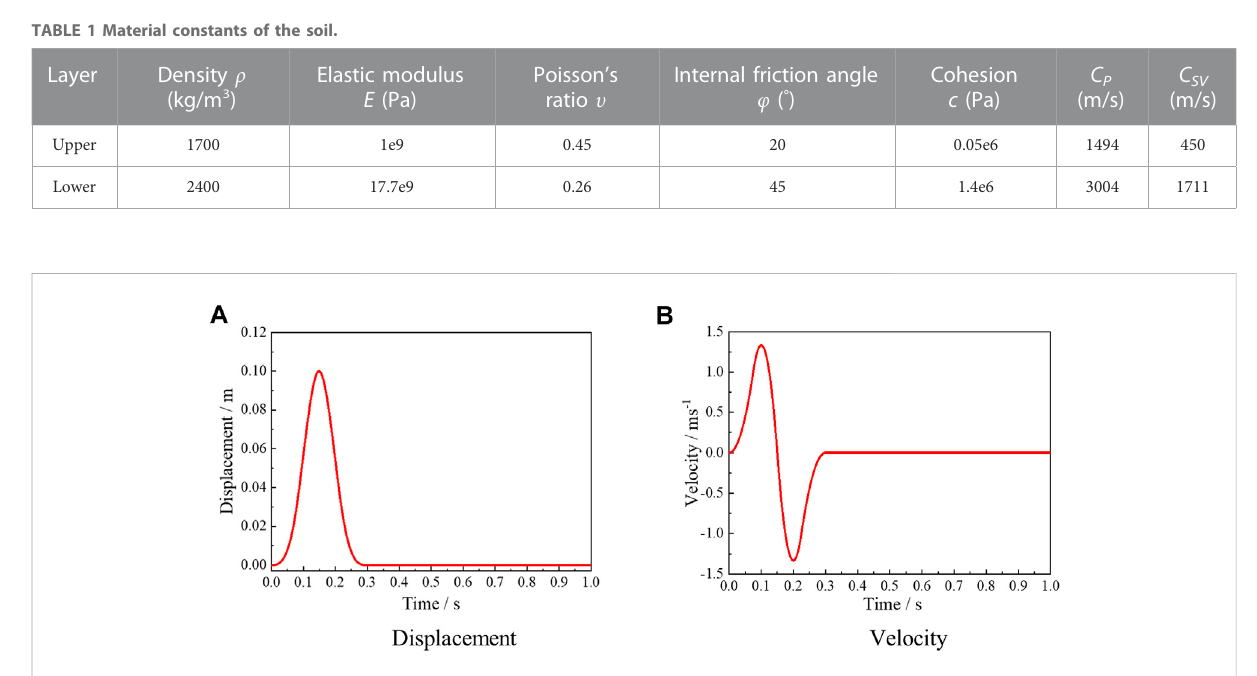
FIGURE 4 Time history curve of the input seismic wave. (A) Displacement. (B)